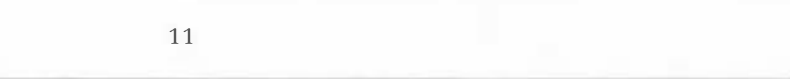
Figure 1 A neolithic beater or club of alder wood (about BOcm long) found in eroding peat deposits exposed on the Thames foreshore at Chelsea and dated by radiocarbon to 3530-3340 ea]